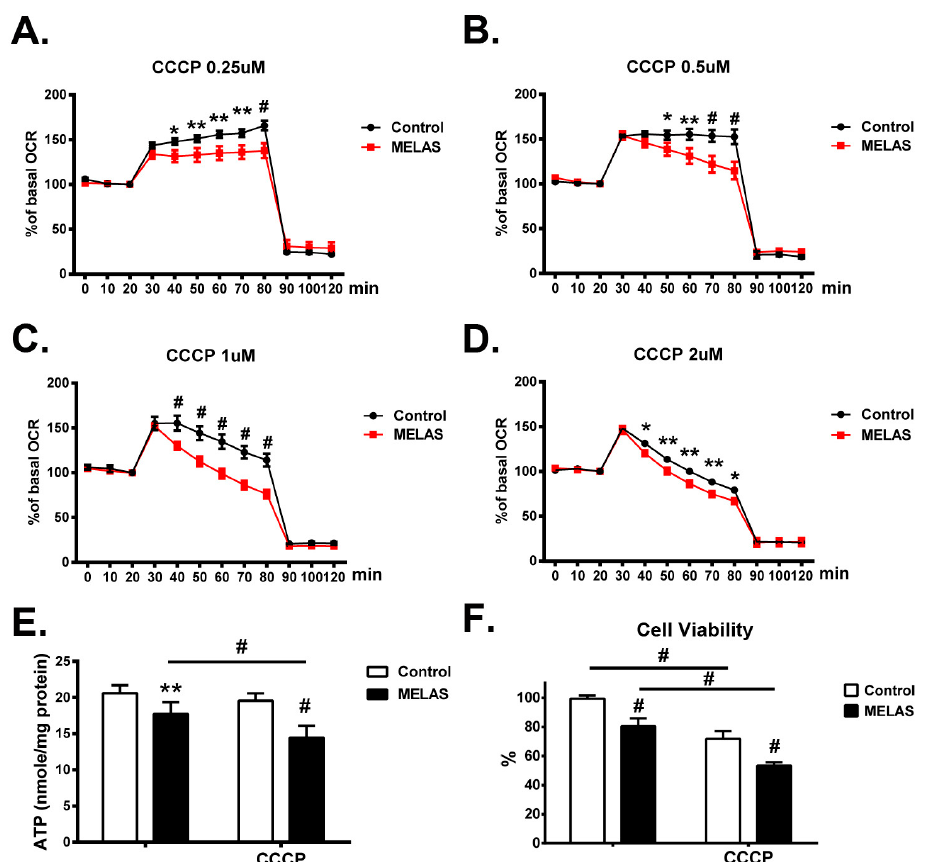
Figure 5. Decreased oxygen consumption rate, ATP production and cell viability. ( A – D )Control cells were able to maintain uncoupled respiration at a higher oxygen consumption rate (OCR) in the presence of CCCP at different concentrations in comparison with MELAS iPS cells. ( E ) Intracellular content of ATP was determined in the presence or absence of CCCP. ( F ) MELAS iPS cells showed a significant decline in cell viability in the presence of CCCP in comparison with control iPS cells. All measurements are expressed as mean values ± SEM, n = 3–5. * p < 0.05, ** p < 0.01, # p < 0.001, versus control.